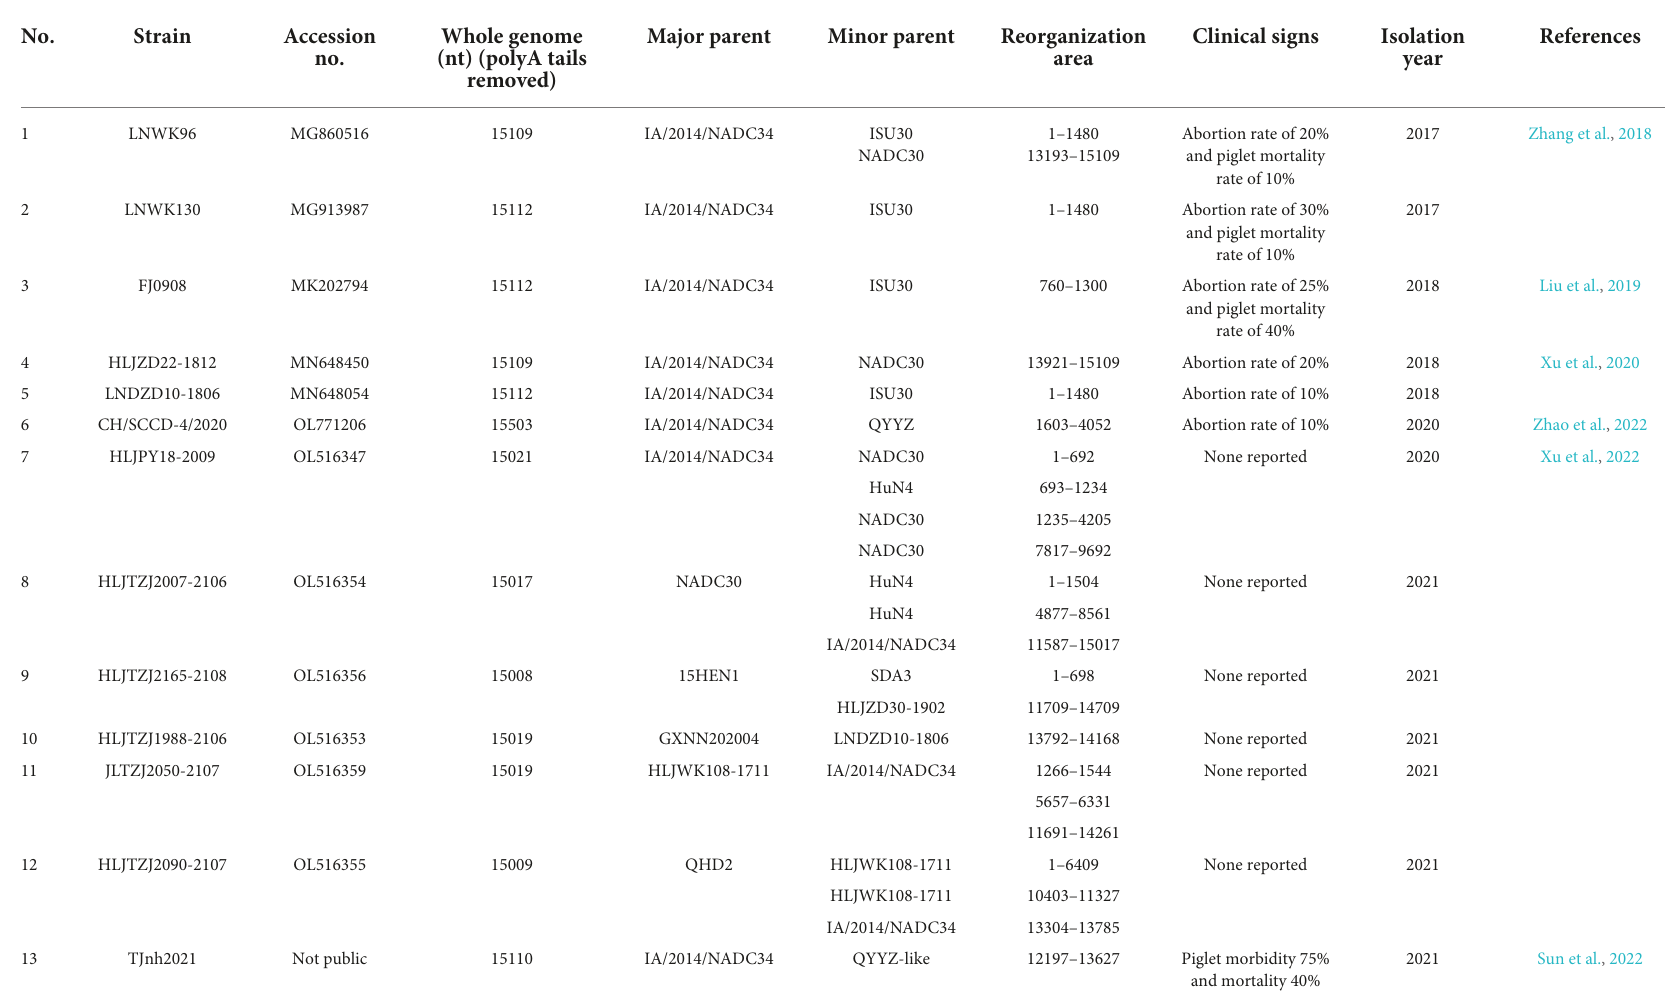
TABLE 1 Recombination information for NADC 34-like strains isolated in